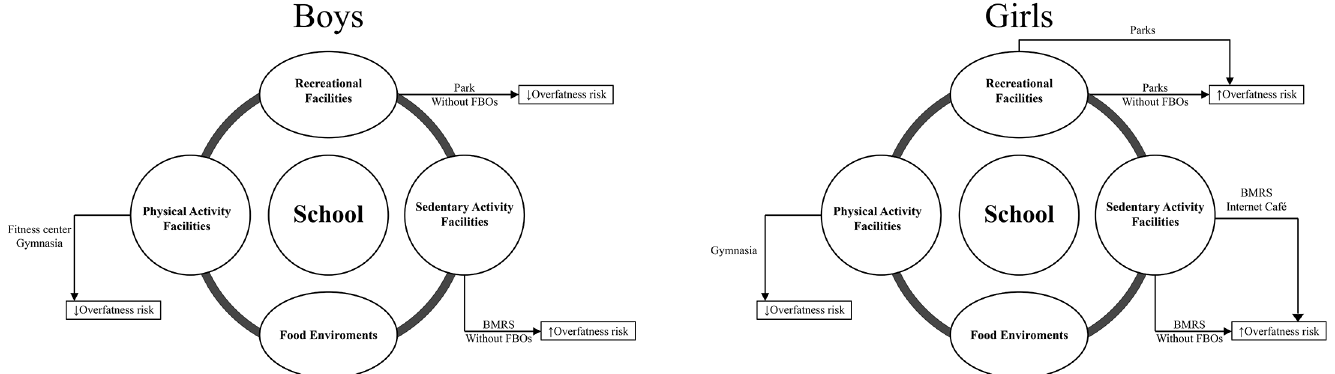
Fig 2. School environmental risk factors for overfatness in boys and girls based on adjusted multivariable regression analyses. “Overfatness” is used to indicate any of the following:(a) BMI (body mass index), (b) TSF (triceps skinfold thickness), and (c) WC (waist circumference). RMRS, reading materialrental shops; FBOs, food and